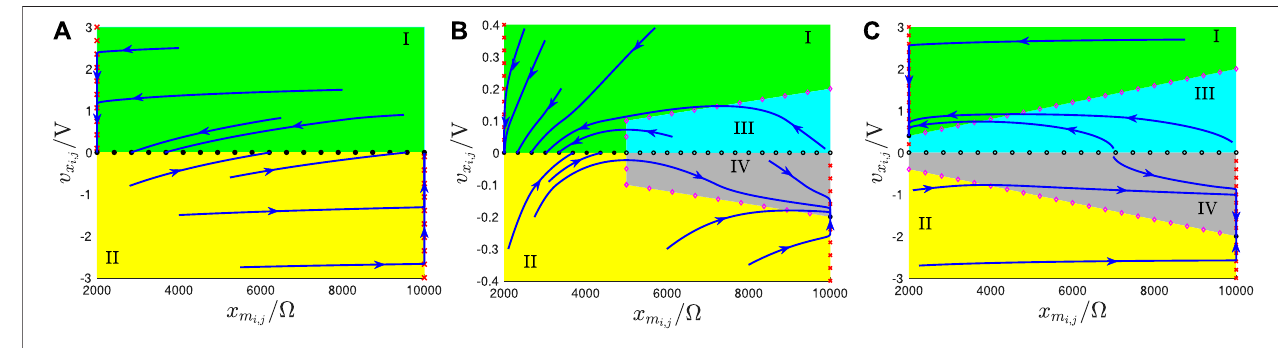
(cid:1) 0A,and G (cid:1) 0 Ω − 1 ,andfeaturingacontinuumofstableequilibria x i , j